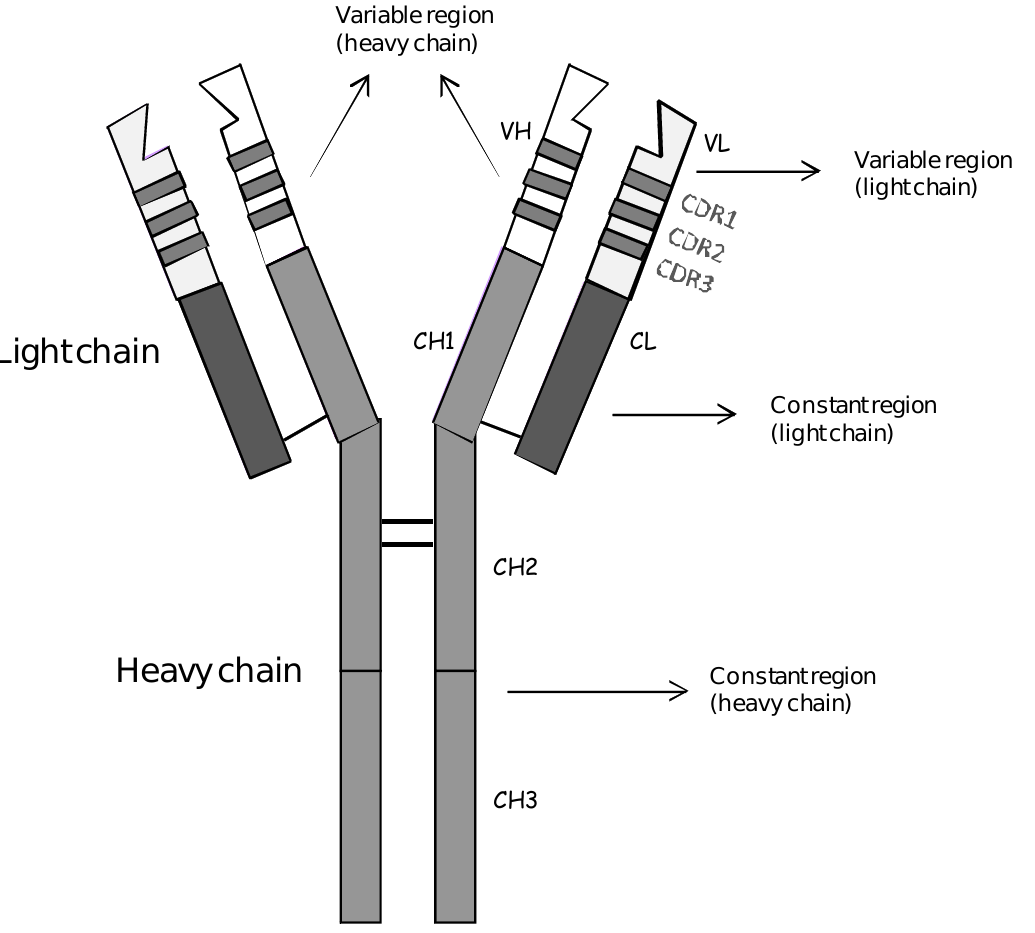
Figure 1. Schematic representation of the structure of a monomeric immunoglobulin. The collection of idiotopes termed idiotype is located within both heavy and light chain variable regions. VH: heavy chain variable region; VL: light chain variable region; CH: heavy chain constant region; CL: light chain constant region; CDR: complementarity- determining